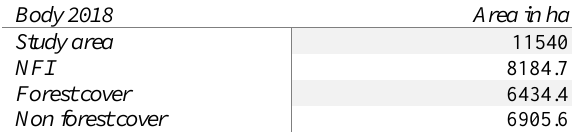
Table 3. National forest inventory NFI and forest cover